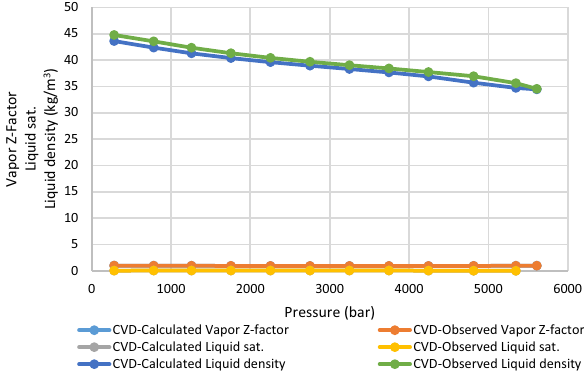
Fig. 3 CVD vapor Z-factor, liquid density and liquid saturation results under laboratory conditions (108.8